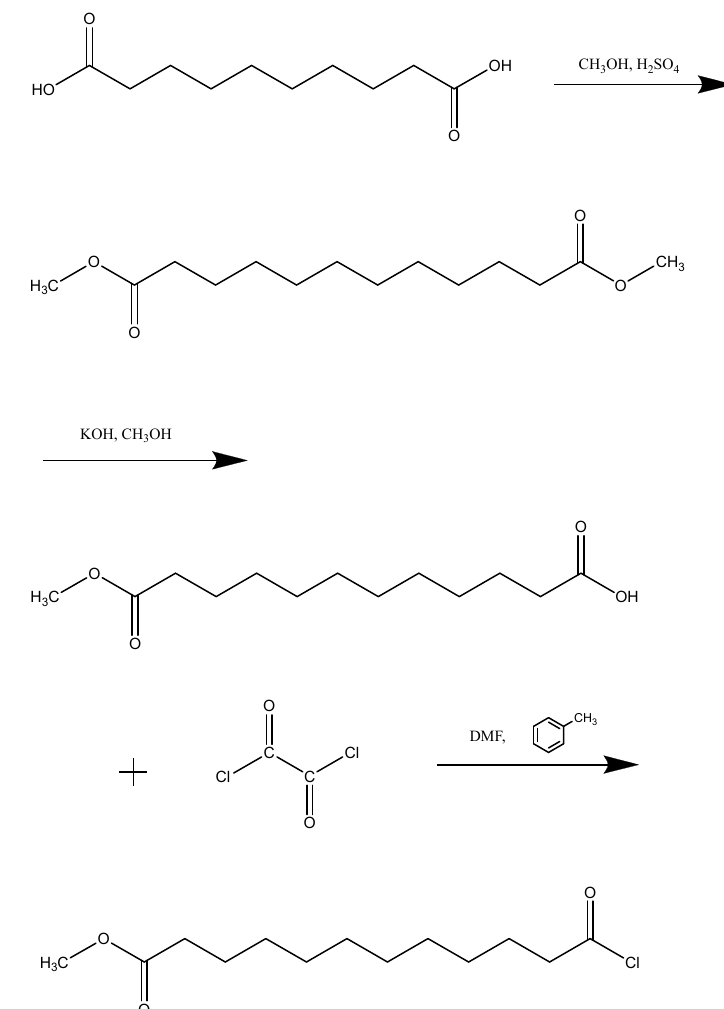
Figure 2. Synthesis scheme of intermediate product; synthesis of 12-chloro-12-oxododecanedioic acid-methyl ester.